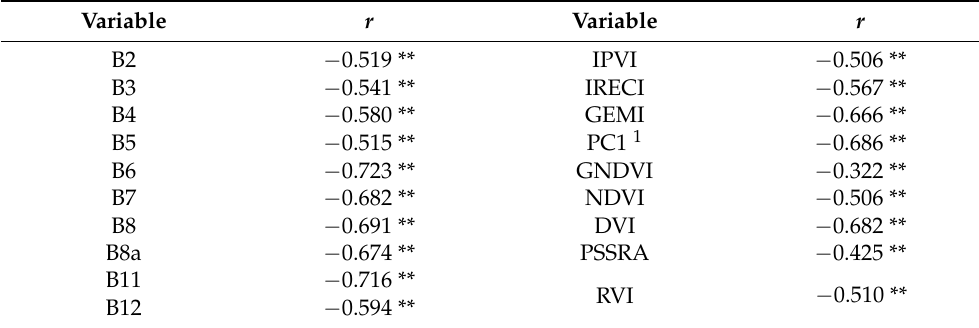
Table 2. Pearson’s correlation coefficient (r) between spectral information and the aboveground biomass (AGB).